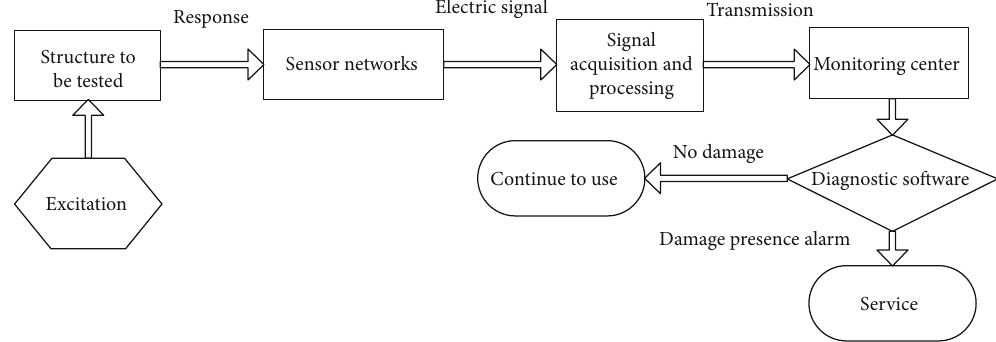
Figure 1: Work fl ow of the health monitoring